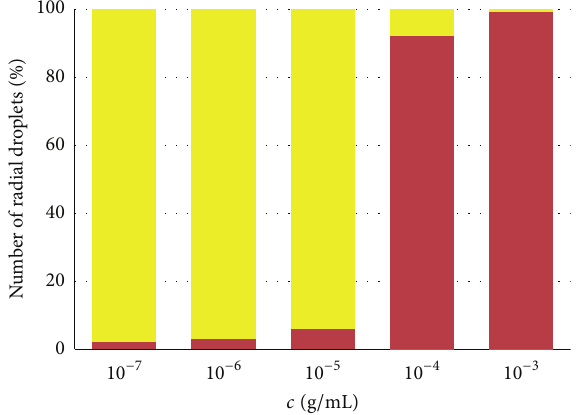
Figure6:RelativenumberofLCdropletsexhibitingradial(red)and bipolar (yellow) nematic structure as a function of 𝑐